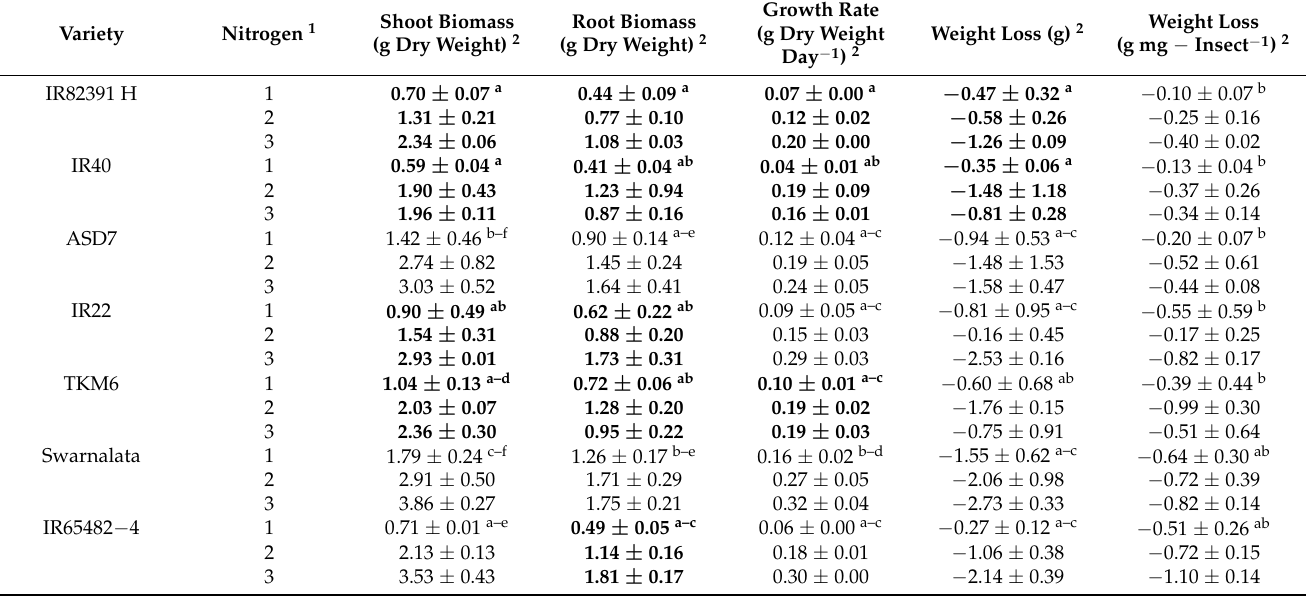
Table 2. Plant growth under varying soil nitrogen levels (1 = zero added nitrogen, 2 = 80 Kg ha − 1 , 3 = 150 Kg ha − 1 ) with plant weight loss due to herbivory, and weight lost per unit weight of nymph, as estimated from the Survival bioassays. Numbers are means ± SEM. For further details see Table